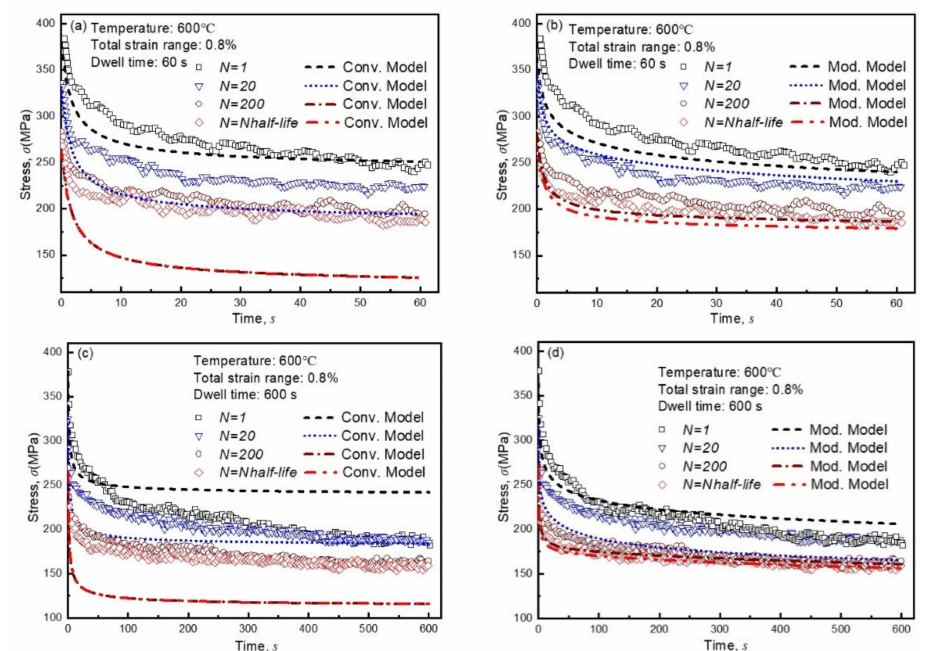
Figure 11. Comparison of simulated stress relaxation during dwell time and experimental results at 0.8% total strain range with di ff erent dwell times under 600 ◦ C: ( a ) 60 s dwell time simulated by the conventional model, ( b ) 60 s dwell time simulated by the modified model, ( c ) 600 s dwell time simulated by the conventional model, ( d ) 600 s dwell time simulated by the modified model.